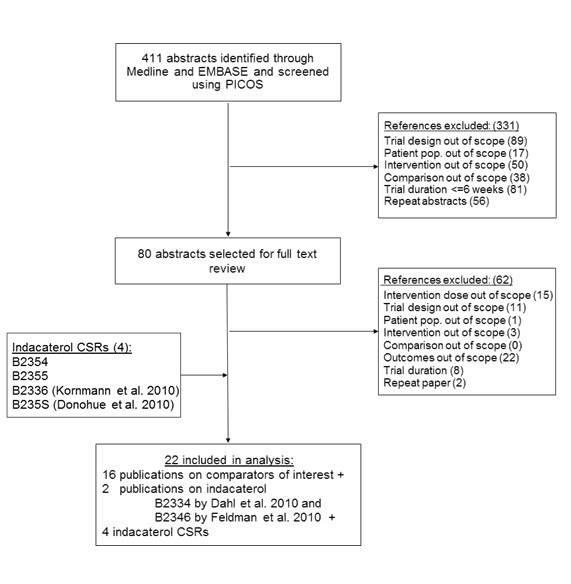
 Flow Diagram of study selection.